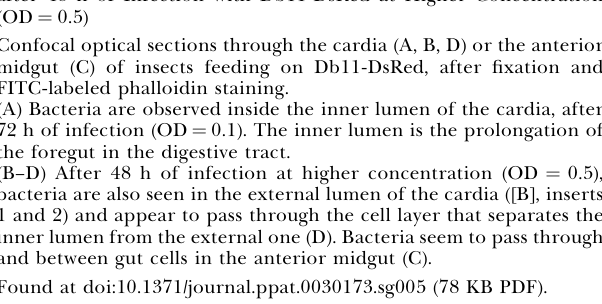
Figure S1. Diptericin Overexpression Confers a Slight Resistance to S. marcescens Infection in the Ingestion but Not in the Septic Injury Model (A) Wild-type, mutants for IMD pathway ( key ) or Toll pathway ( Dif ), and Diptericin overexpressing flies (Hsp-Dipt: flies carrying UAS- Diptericin and the strong hsp-Gal4 driver transgenes were placed at 37